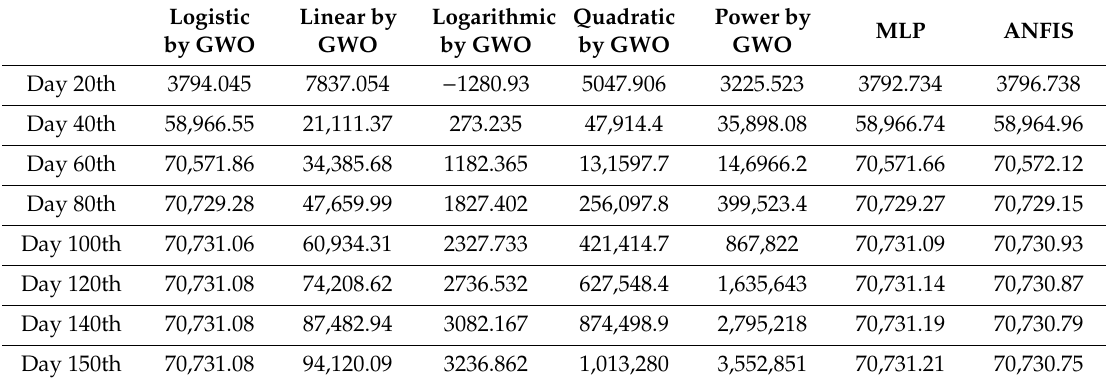
Table 17. The outbreak prediction for Italy through 150 days.